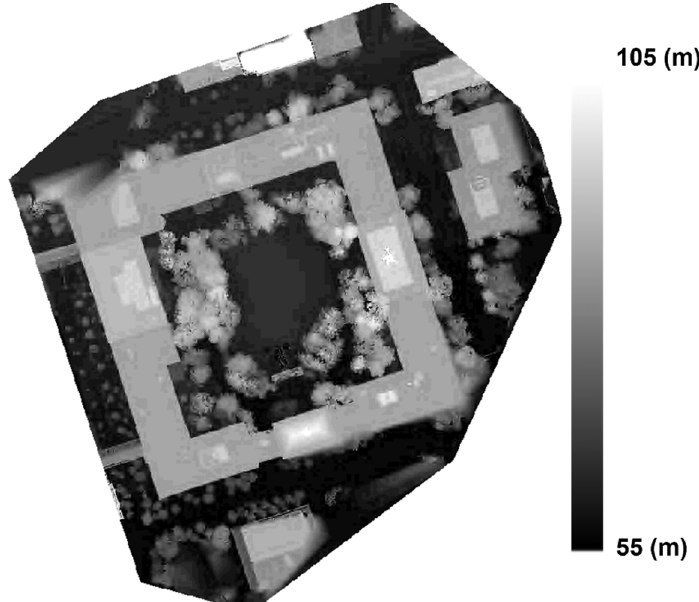
Figure 16. DSM raster generated using the solid-state LiDAR data point cloud for the second test site.